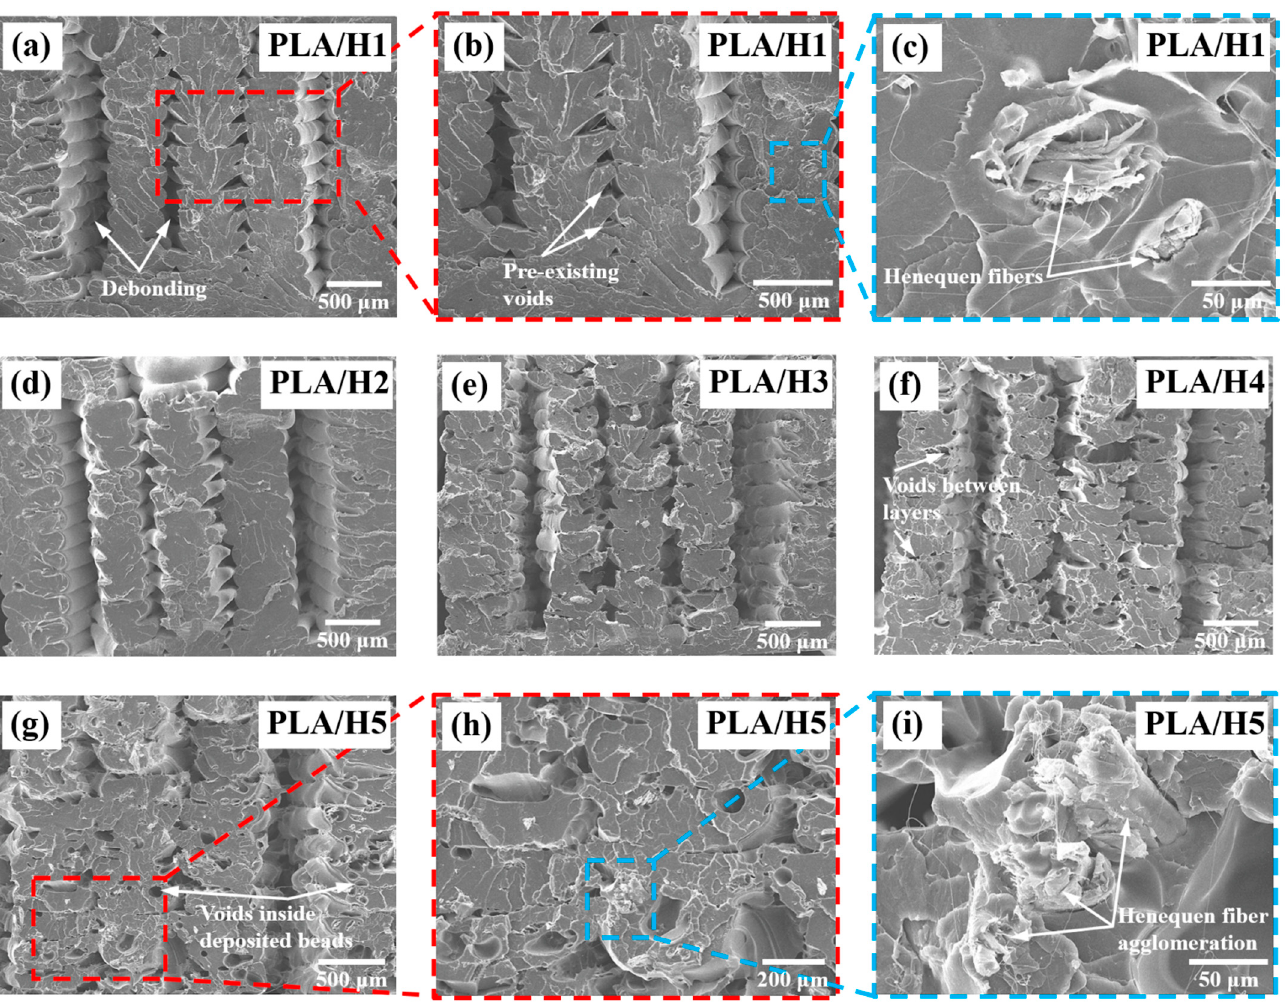
Figure 8. SEM images of the fracture surfaces after tensile testing of the 3D printed NFRCs: ( a ) PLA/H1; ( b ) PLA/H1 (close-up view); ( c ) PLA/H1 (close-up view); ( d ) PLA/H2; ( e ) PLA/H3; ( f ) PLA/H4; ( g ) PLA/H5; ( h ) PLA/H5 (close-up view); ( i ) PLA/H5 (close-up view).